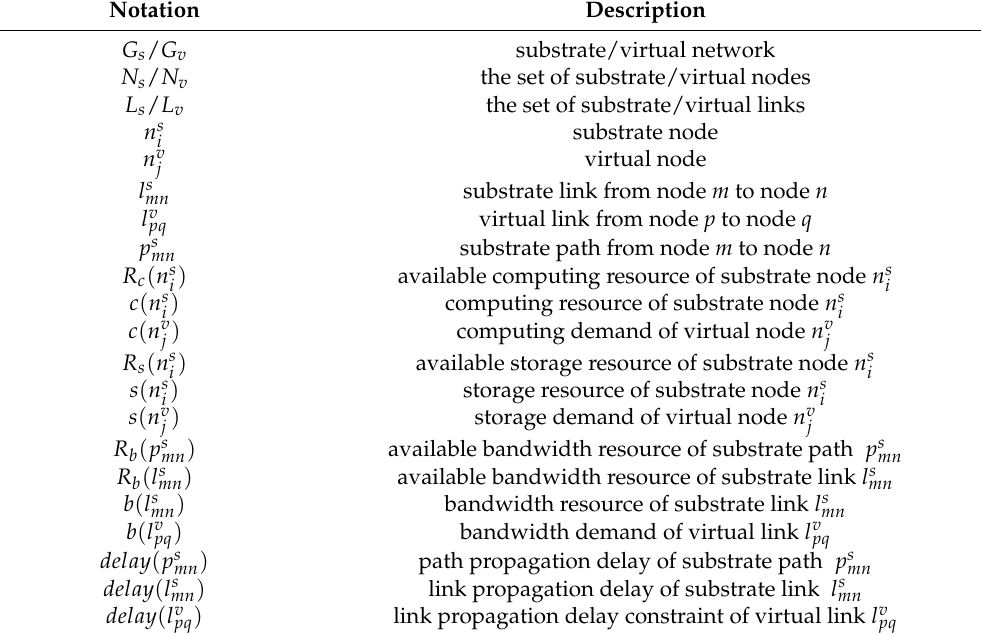
Table 1. Notations in